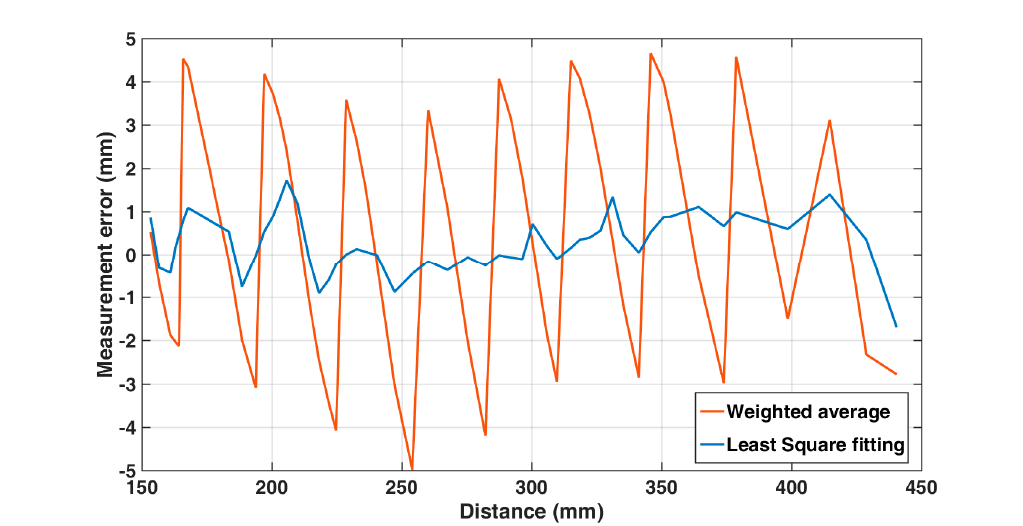
Figure 6. Positioning error throughout the central 300 mm stroke of the pneumatic